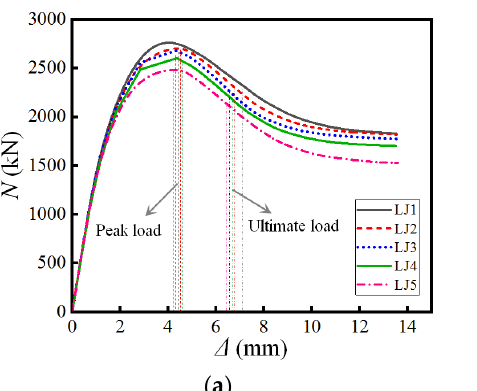
Figure 15. Different pitch. ( a ) Load–displacement curve ( b ) Performance Changes.